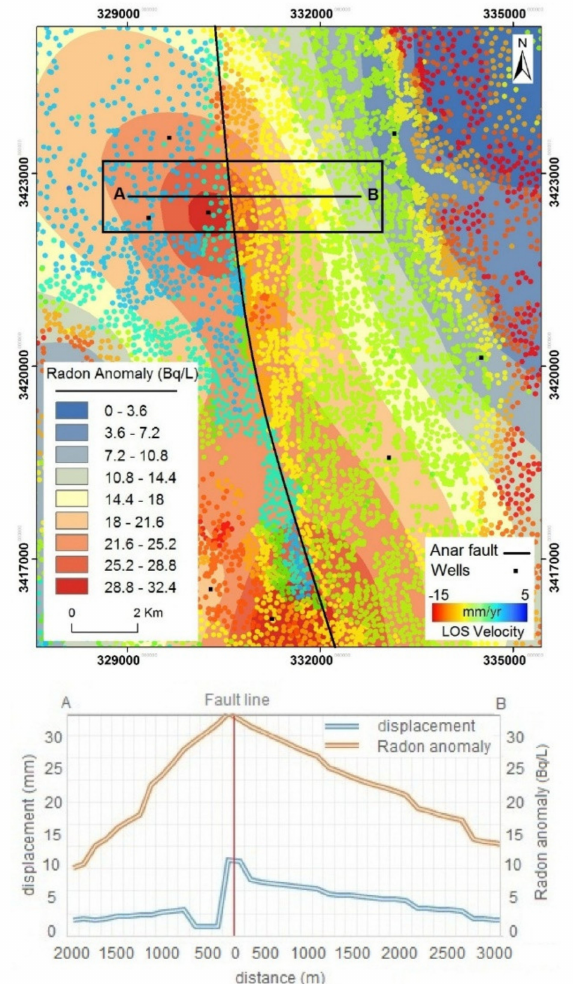
Figure 13. Displacement rate and radon anomaly cross-section profiles highlight a good correlation of Rn and displacement rate peaks with the fault trace.